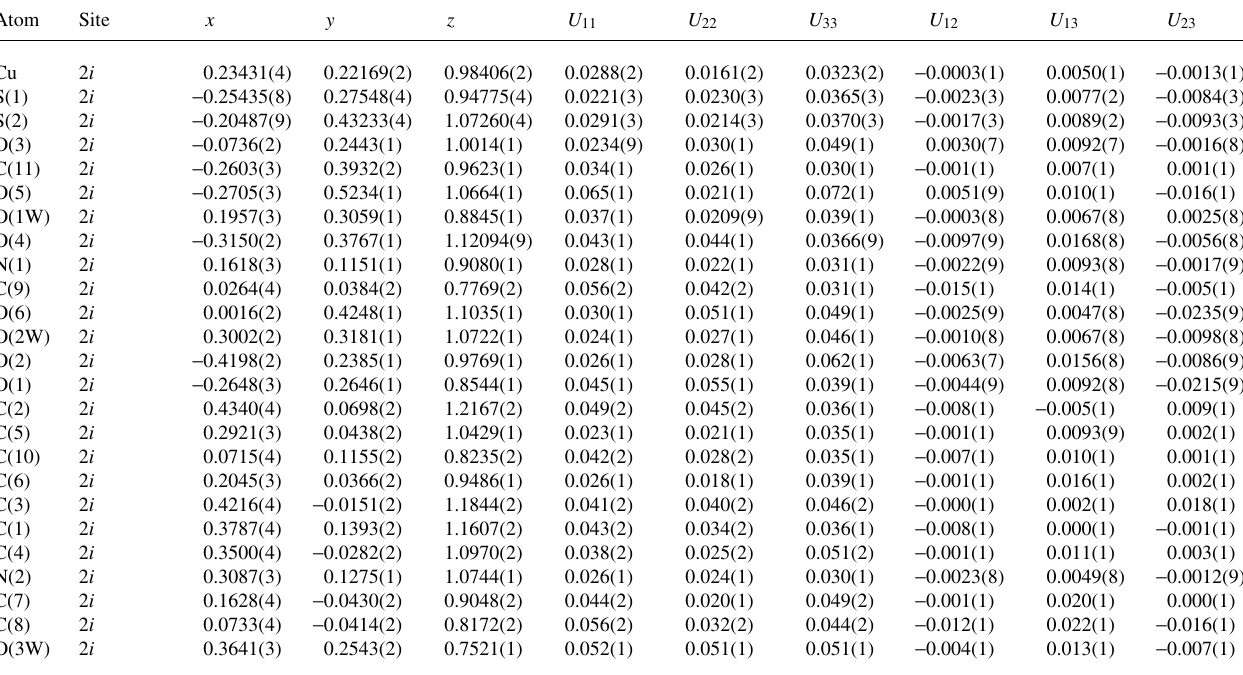
Table 3. Atomic coordinates and displacement parameters (in Å 2 )